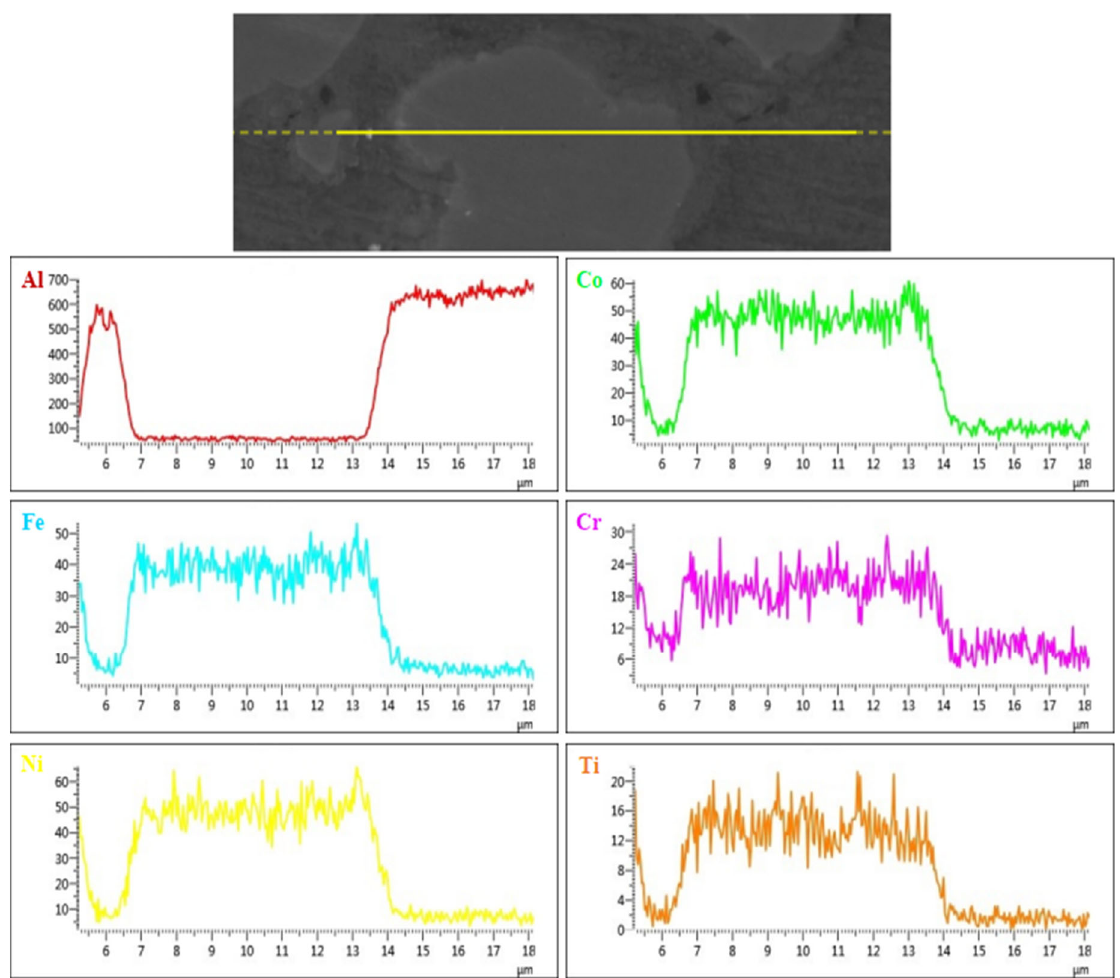
Figure 7. Line scan analysis of 10 vol.% HEA composite material.